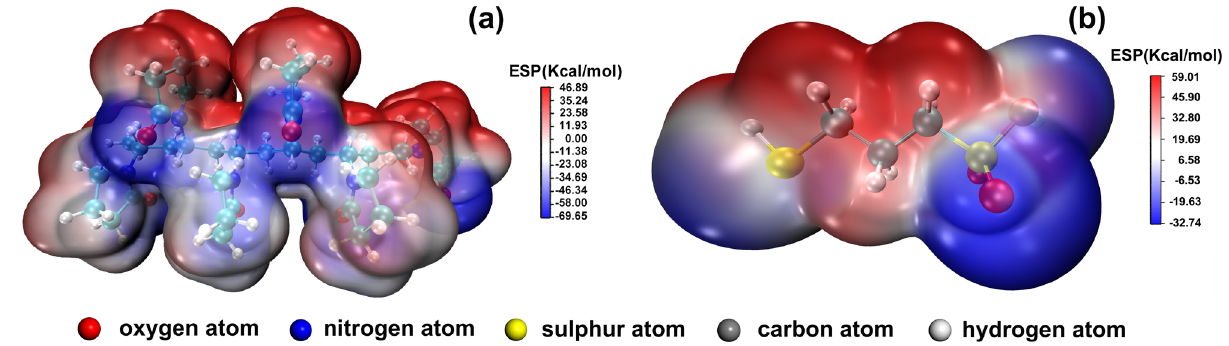
Figure 4: Electrostatic potential distribution on the surface of molecular van der Waals of PVP containing six monomers ( a ) and MPS ( b )